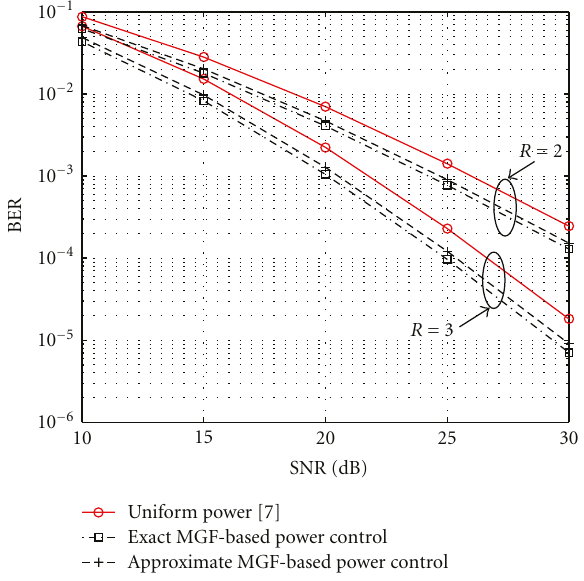
Figure 6: Performance comparison of AF DSTC with di ff erent power allocation strategies in a network with two and three relays and using BPSK